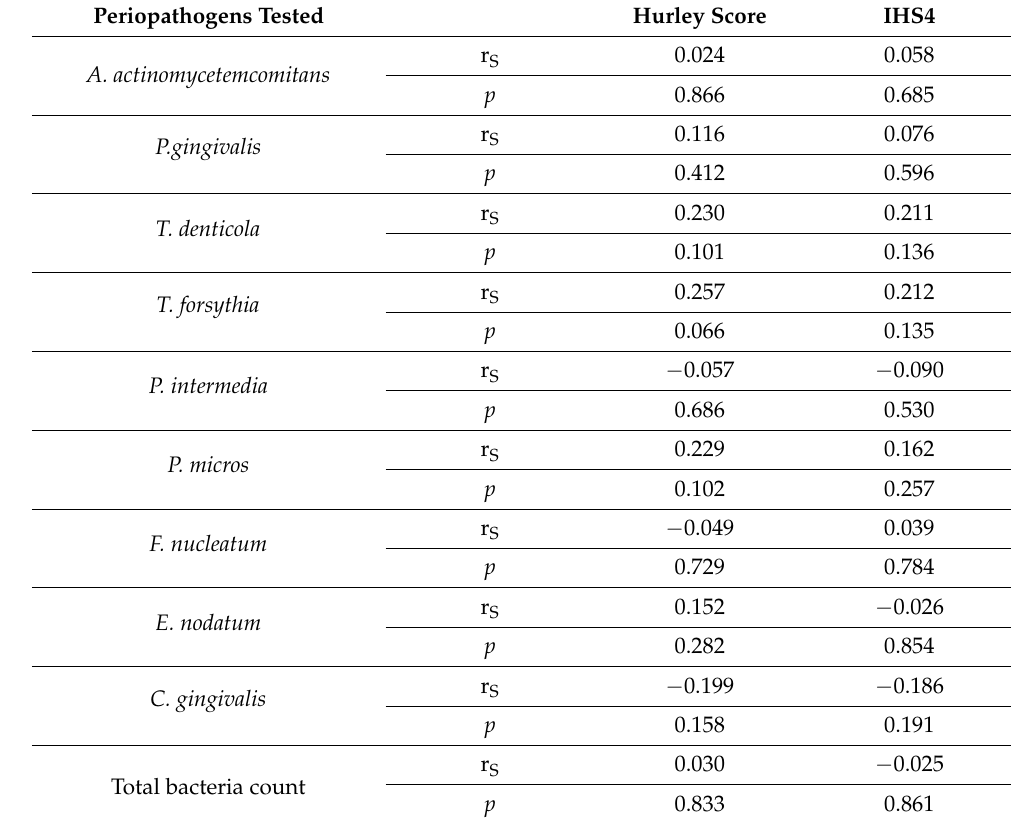
Table 5. Spearman correlation coefficient (r S ) between Hurley and IHS4 scores and DNA copy number of periopathogens and total